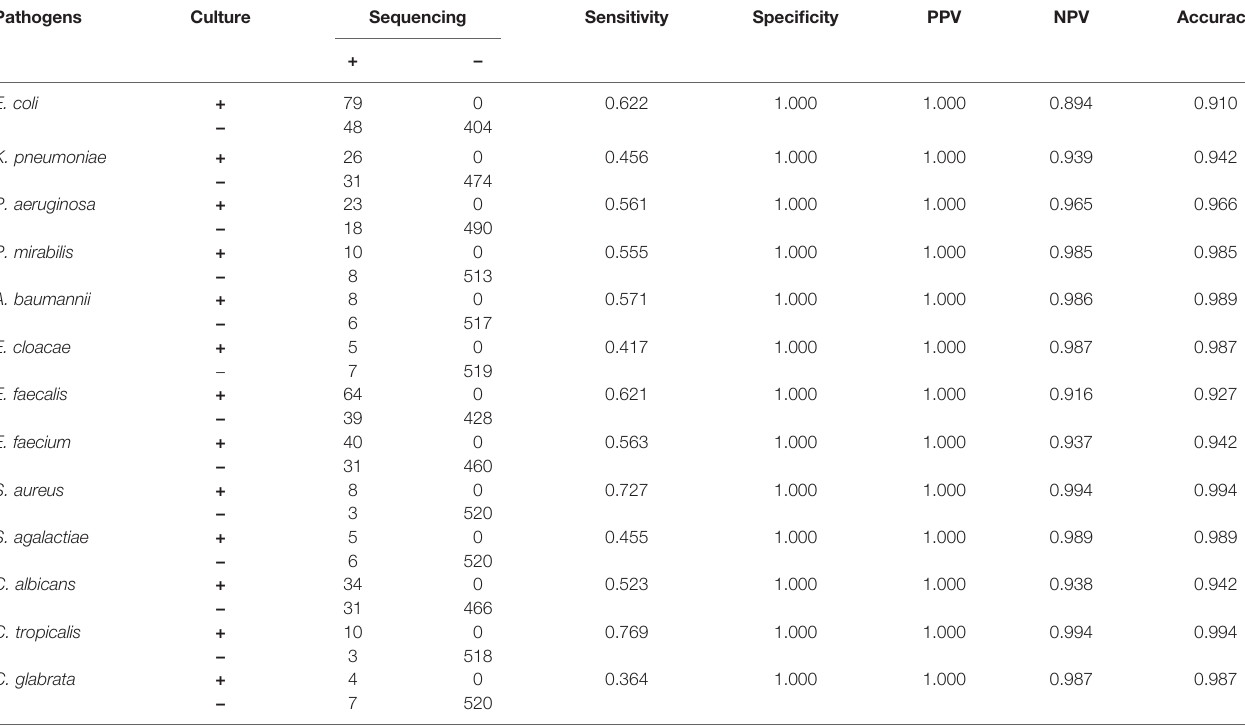
TABLE 1 | A comparison of conventional methods and Sanger sequencing for the detection of individual uropathogens . Pathogens